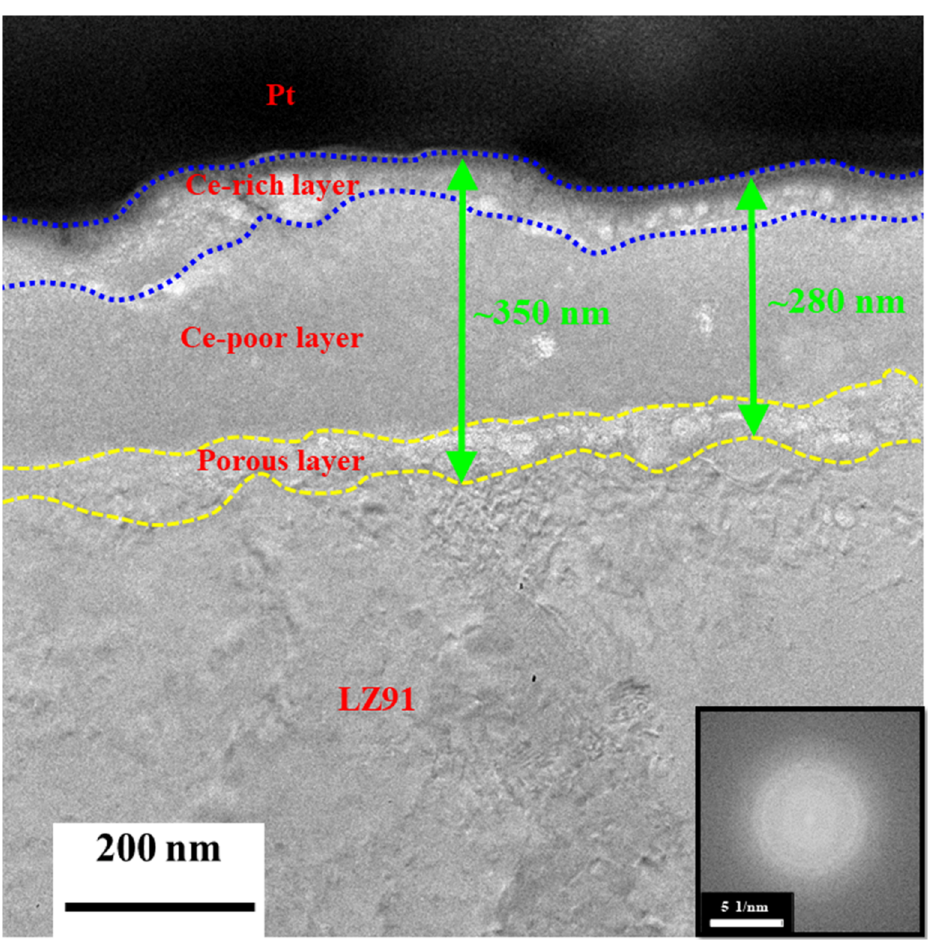
Figure 11. TEM image showing the cross-sectional morphology of the conversion coating on LZ91 Mg alloy.